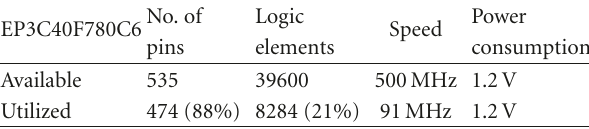
Table 3: Number of circuits for serial realization.